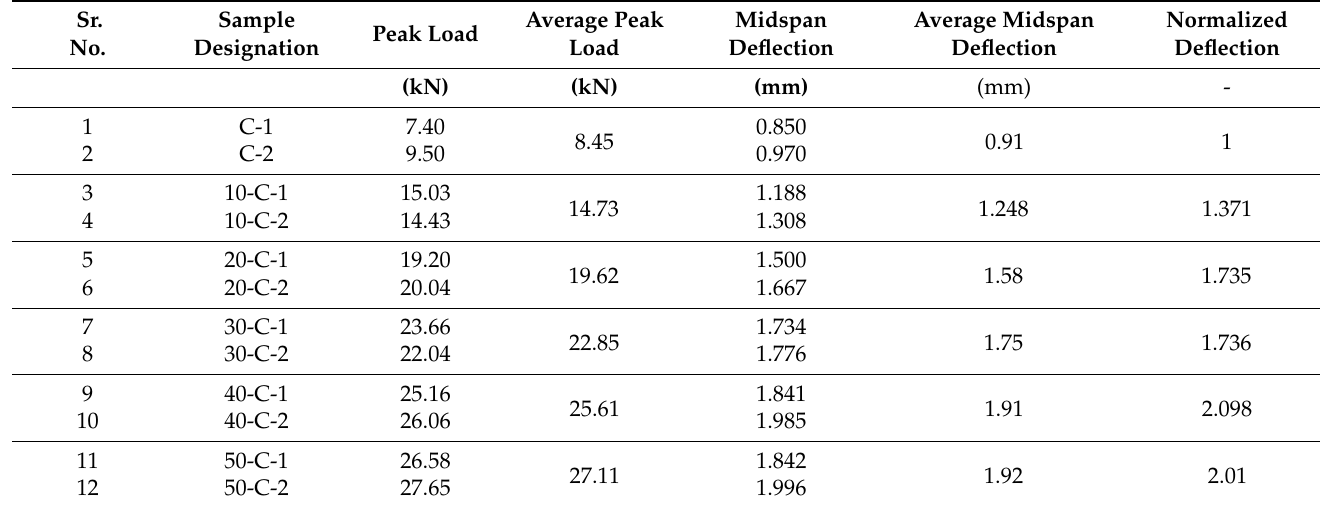
Table 5. Experimental results summary of peak load and mid-span deflection.